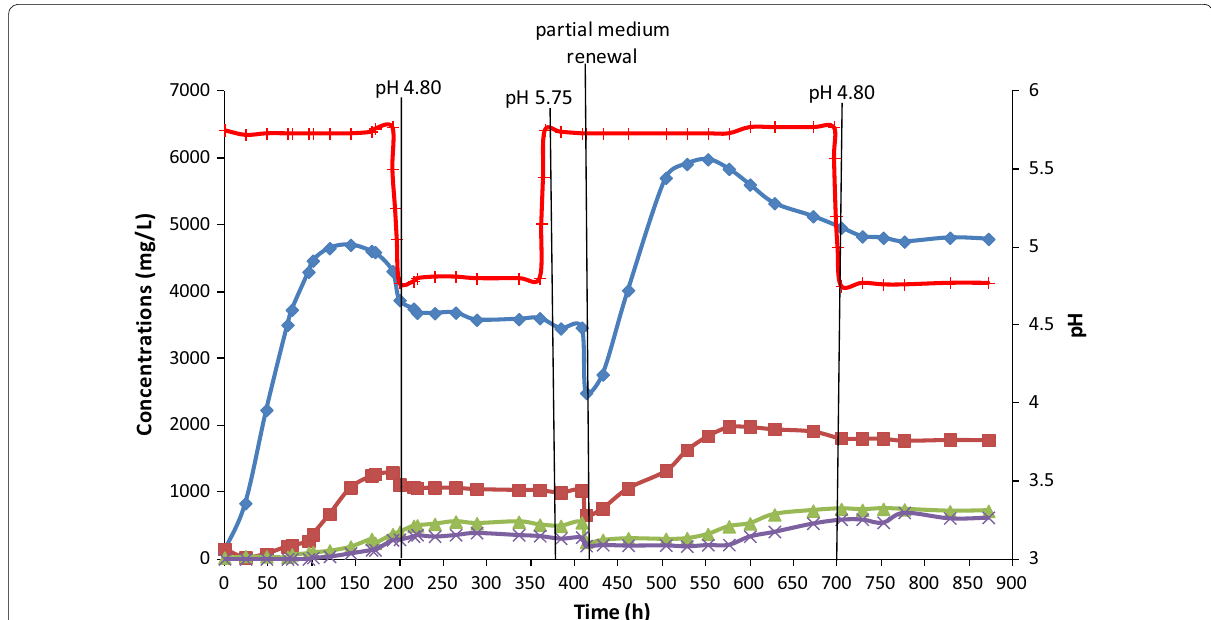
Fig. 1 Fermentation products expressed in mg/L over time in continuous gas‑fed bioreactor. (Acetic acid represented as filled diamond, butyric acid represented as filled square, ethanol represented as filled triangle and butanol represented as